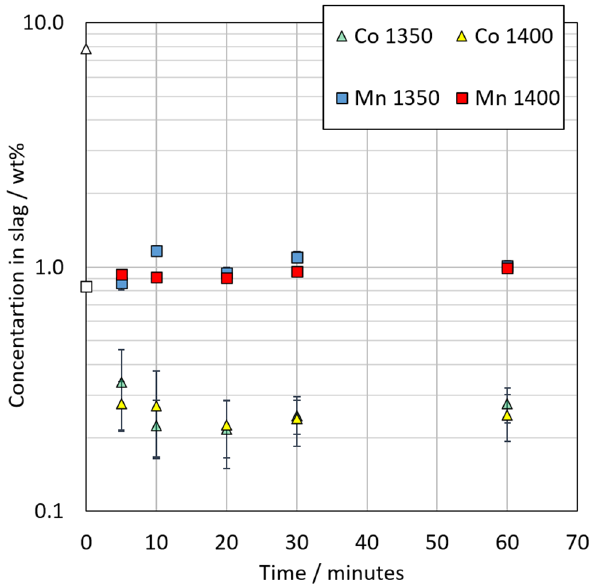
Figure 13. Cobalt and manganese concentrations (logarithmic scale) in the slag as a function of contact time in argon atmosphere. The values at 0 minutes correspond to the elemental concentrations in the starting mixture.